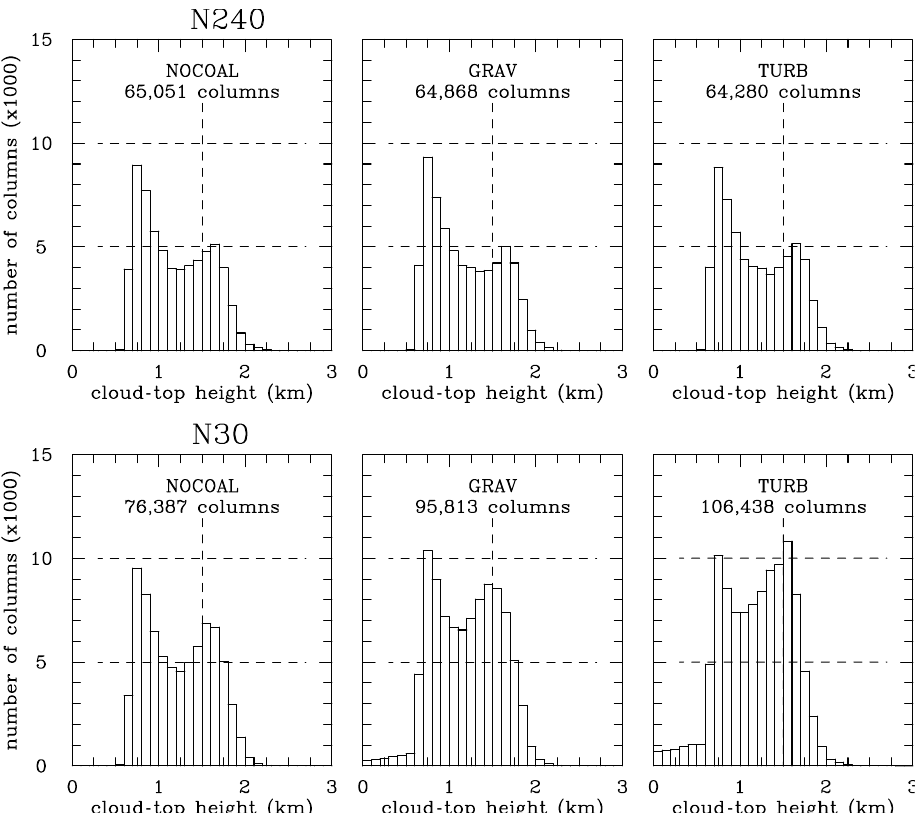
Figure 1. Histograms of the cloud-top height for NOCOAL, GRAV and TURB simulations N240 and N30 for the last 3h of model simula- tions. The bin width is 100m. The number of model columns included in each histogram is shown in the panels.